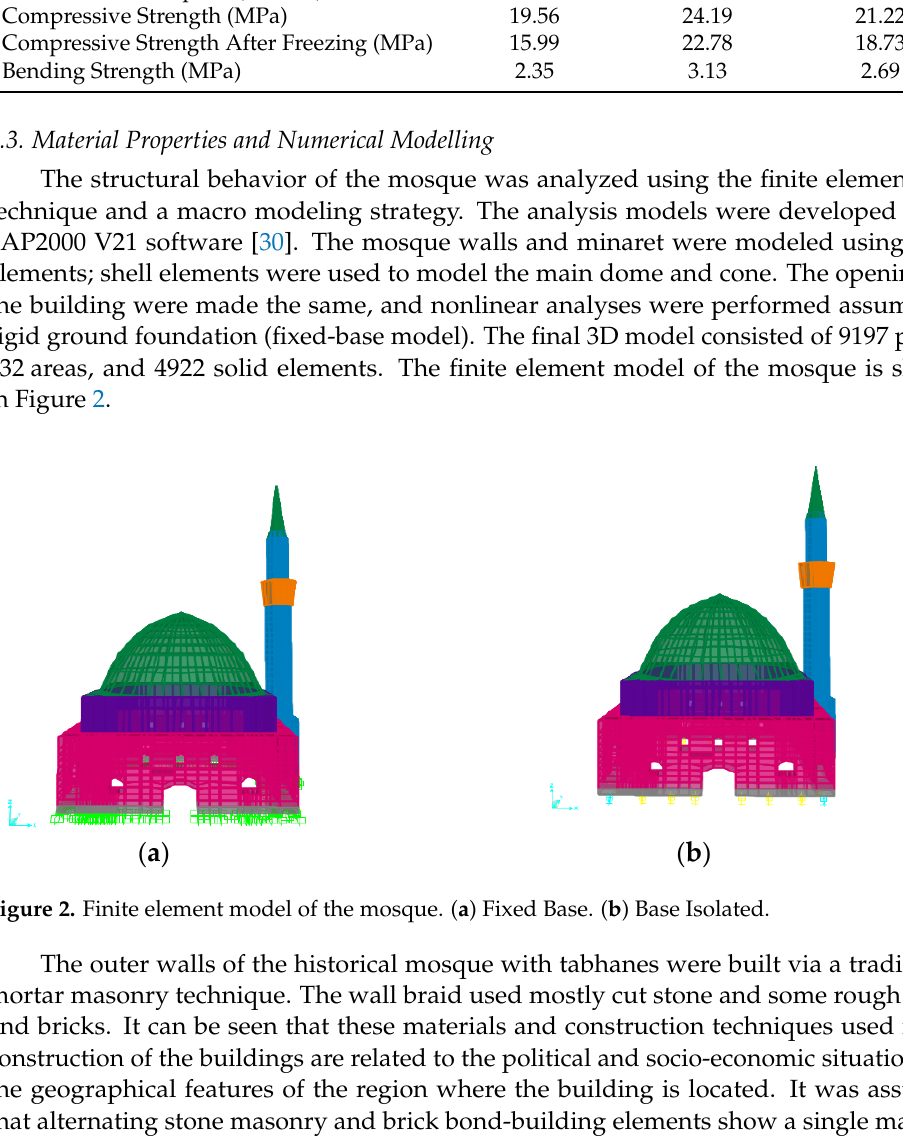
Table 1. The mechanical properties of Afyon tuffs rocks.